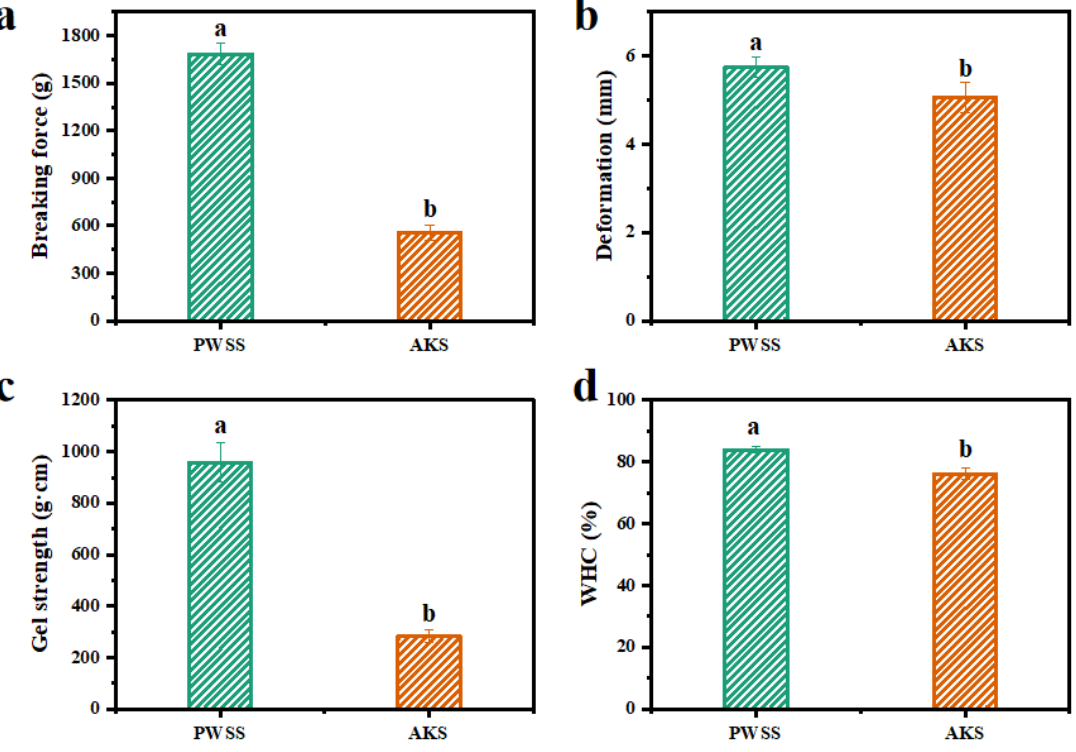
Figure 1. Gel strength and water-holding capacity of Antarctic krill and Pacific white shrimp surimi gels: ( a ) Breaking force, ( b ) deformation, ( c ) gel strength, and ( d ) water-holding capacity. Different letters indicate significant differences ( p < 0.05). PWSS, Pacific white shrimp surimi; and AKS, Antarctic krill surimi.